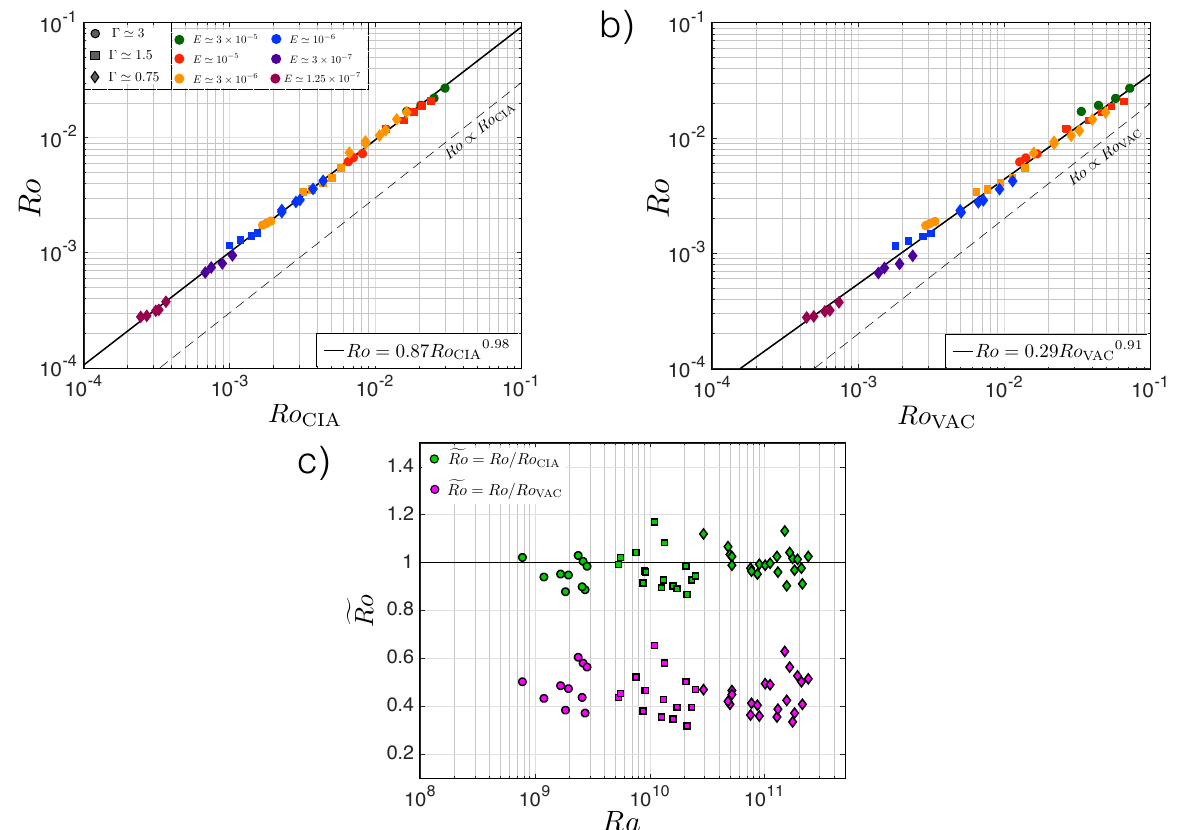
Figure 8. ( a ) Ro vs. Ro CIA using laboratory data, where the best fitfit black line is given as Ro = 0.87 Ro CIA0.98 . The use of colors and symbol shapes is consistent with that of Figure 7. ( b ) Ro vs. Ro VAC , where the best fitfit black line is given as Ro = 0.29 Ro VAC0.91 . ( c ) Normalized Rossby Ro , vs. Ra , where the green symbols contain a normalization on the y-axis of Ro = Ro / Ro CIA , number, Ro = Ro / Ro VAC . The green CIA normalized points and the magenta symbols are a y-normalization of (cid:102) (cid:102) are centered around 1, indicating that the CIA scaling estimates the measured values well, while the (cid:102) magenta VAC scaling overestimates the measured Ro values by roughly a factor of